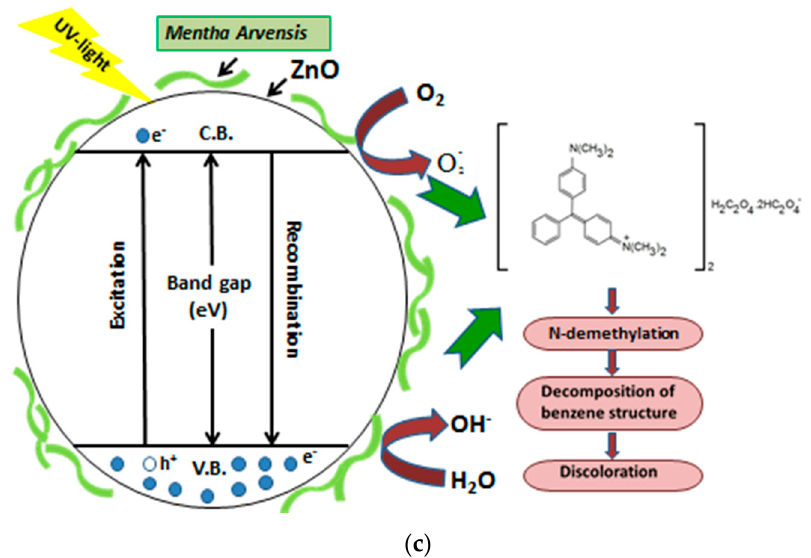
Figure 11. Kinetic curves of UV-discoloration of Malachite Green dye using G0, G1, and G2 photocatalysts ( a ); Kinetic curves of UV-discoloration using the G2 photocatalyst after three consecutive photocatalytic cycles ( b ); Probable mechanism of the UV-induced discoloration of the MG dye using Mentha arvensis -mediated ZnO ( c ).